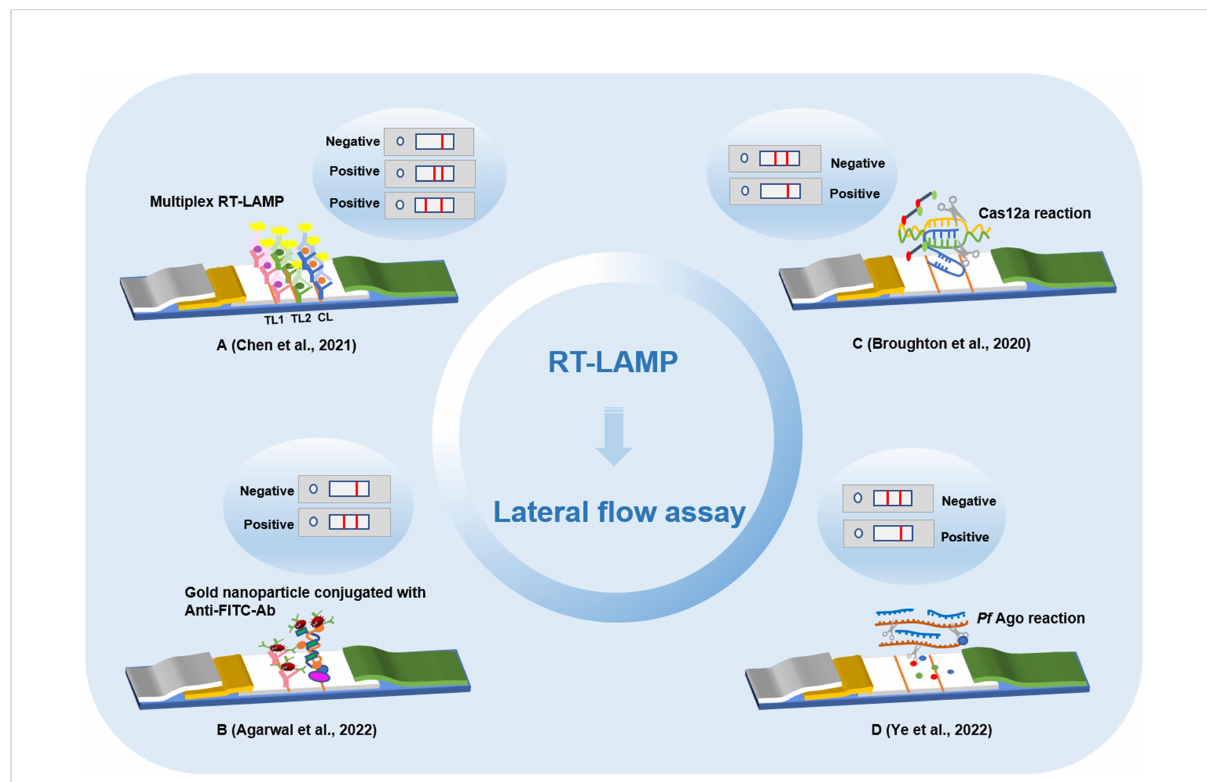
FIGURE 2 Detection method of lateral fl ow assay based on loop-mediated isothermal ampli fi cation technology. (A) Multiplex reverse transcription loop- mediated isothermal ampli fi cation linked with gold nanoparticle-based lateral fl ow assay. (B) Lateral fl ow assay with enzyme incorporation of biotin labeled dUTP. (C) Lateral fl ow assay based on loop-mediated isothermal ampli fi cation and Cas12a. (D) Lateral fl ow analysis of Argonaute integrated loop-mediated isothermal ampli fi